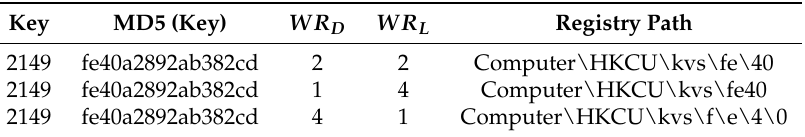
Table 3. The example of the registry path in